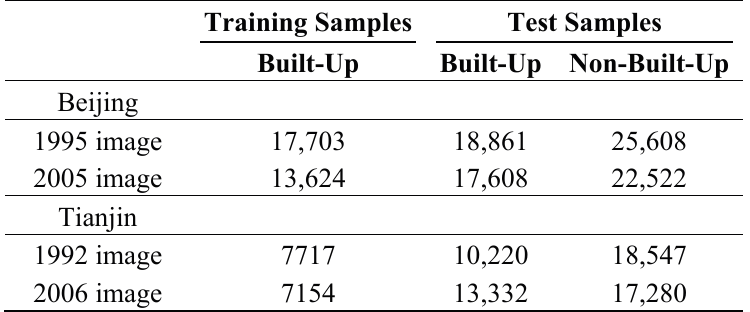
Table 1. Training and test samples used for the two study areas (pixels).